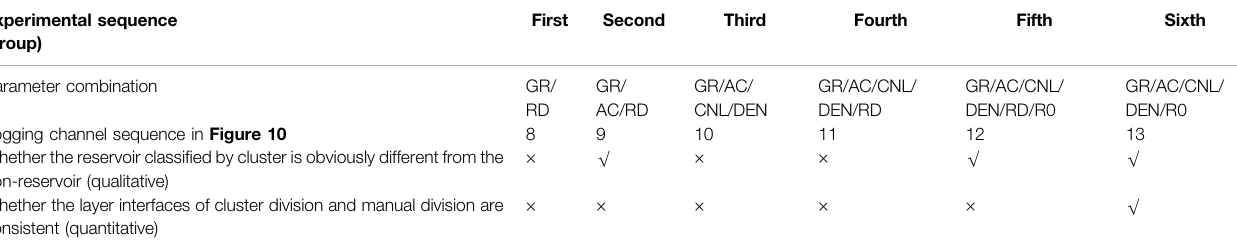
TABLE 2 | Comparison of effects of automatic cluster division of logging facies with different parameter combinations. Experimental sequence